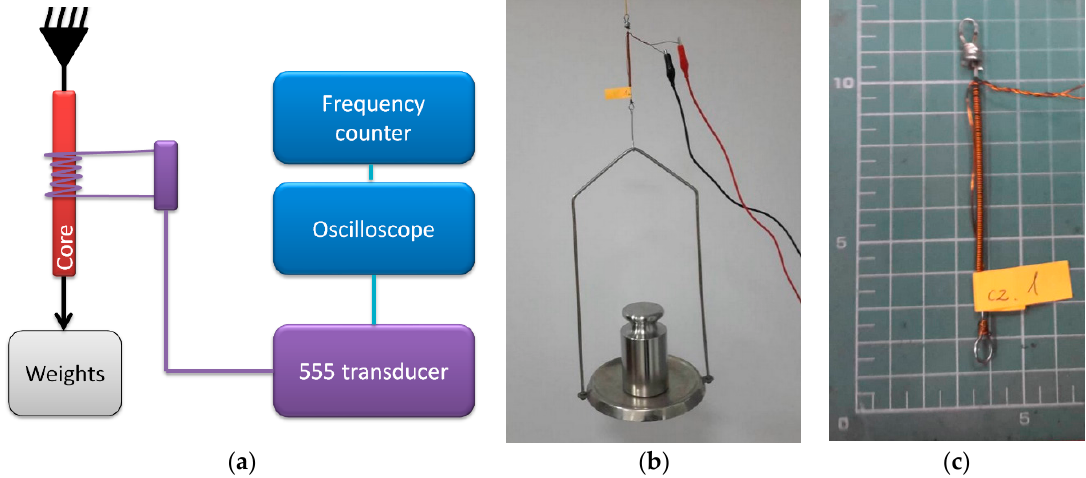
Figure 5. ( a ) Schematic diagram of measurement test stand for magnetoelastic force sensor calibration; ( b ) photo of measurement stand; ( c ) photo of developed magnetoelastic sensor.